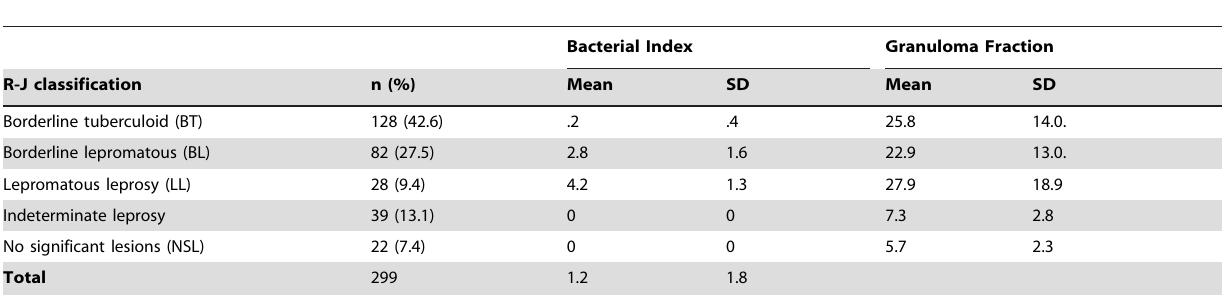
Table 1. Ridley-Jopling classification, Bacterial Index and Granuloma Fraction for skin biopsies.